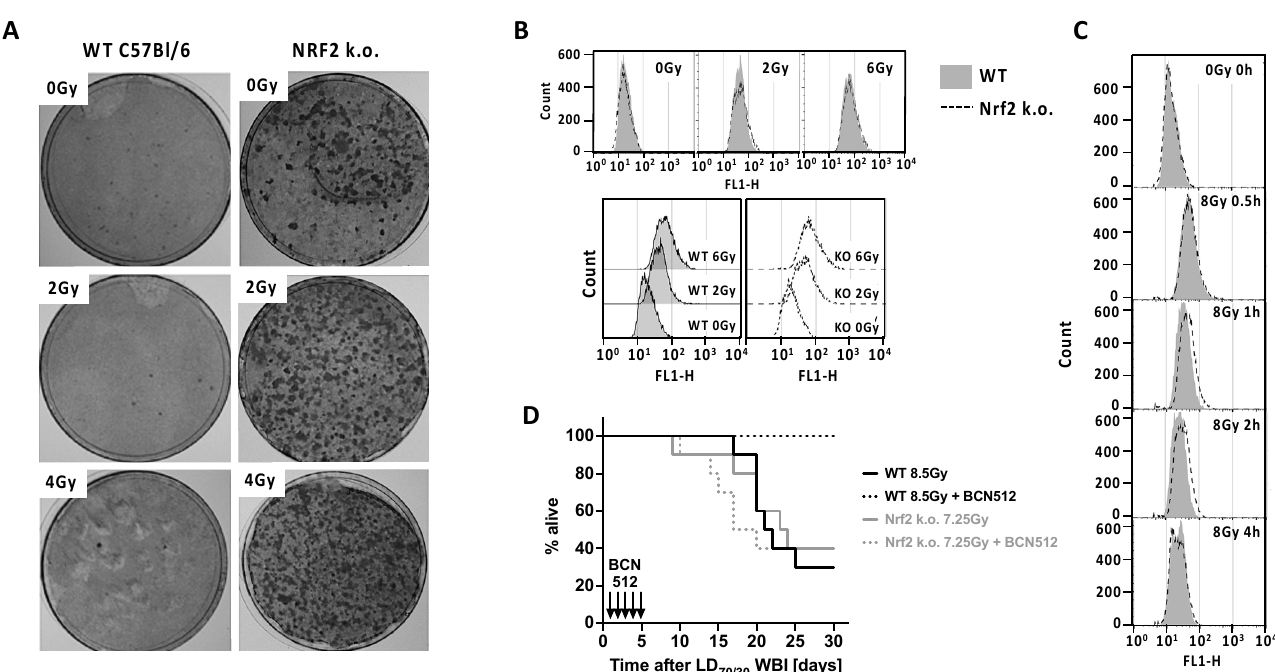
Figure 1. ( A ) Focus formation by primary MEFs from embryos of Nrf2 knock out is considerably greater than in WT C57Bl/6 mice, a difference that was amplified by IR. MEFs were grown for <3 passages before irradiation with 0, 2, or 4 Gy. After 2 days culture to allow for DNA damage fixation, cells were plated in 10 cm dishes and after 3 weeks cells were fixed and stained to visualize foci. Shown are representative plates of n = 3 replicates that was reproducibly repeated in a second experiment. ( B ) A γ –H2AX flow cytometry assay was used to assess DNA DSBs 1 h after irradiation in n = 20,000 cells/sample and repeated once. IR increased γ –H2AX in a dose-dependent fashion, but there was no difference between Nrf2–/– and WT MEFs in levels of basal or IR-induced (2 or 6 Gy) DNA DSBs. ( C ) Repair of DSBs was assessed by incubating 8 Gy irradiated cells for varying time periods before γ –H2AX assay. Repair was slightly slowed in Nrf2 k.o. MEFs compared to WT at 1 and 2 h, but this was transient and there was no difference at 4 h and thereafter (not shown). Data are representative histograms of n = 20,000 cells/sample. ( D ) Nrf2 k.o. and WT C57Bl/6 mice were given WBI at LD70/30 values estimated from probit analysis. Twenty-four hours later the mitigator BCN512 was injected s.c. at 5 mg/kg in 1% Cremophor EL and hARS lethality assessed over 30 days. BCN512 was effective only in WT mice indicating the mitigator activity was NRF2-dependent. n = 10